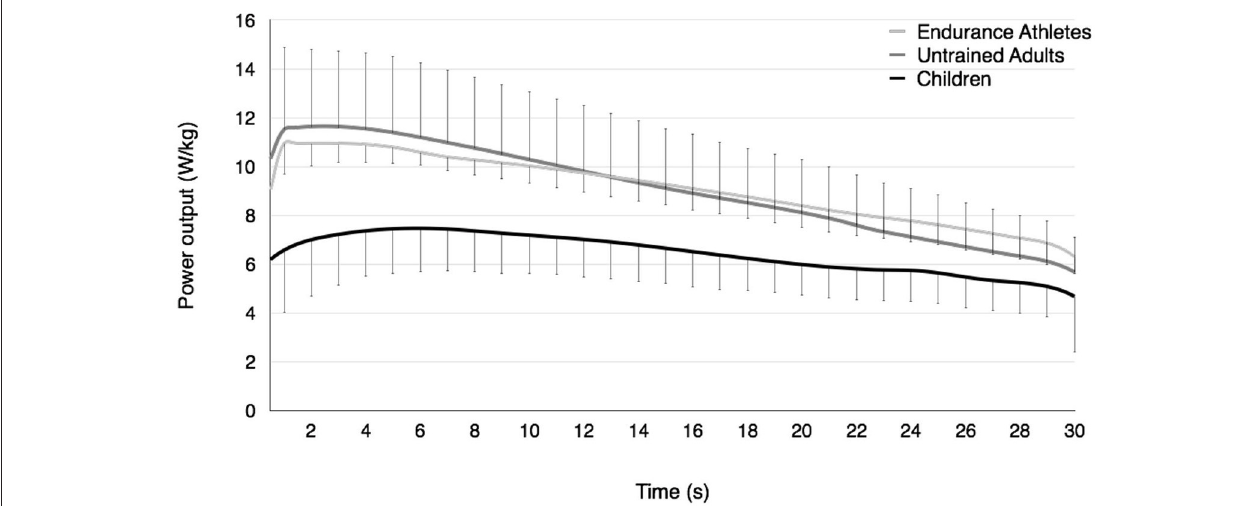
FIGURE 1 | Time course of power output during the Wingate test in prepubertal children, untrained adults, and well-trained adult endurance athletes. The relative decrement in power output (i.e., the fatigue index) is higher in untrained adults than children and well-trained adult endurance athletes but similar in children and well-trained adult endurance athletes.